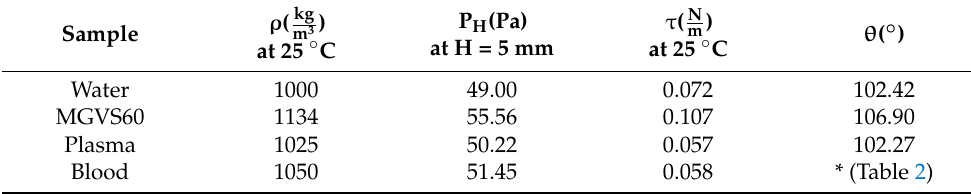
Table 1. Characteristic values for water, MGVS60 plasma, and blood.